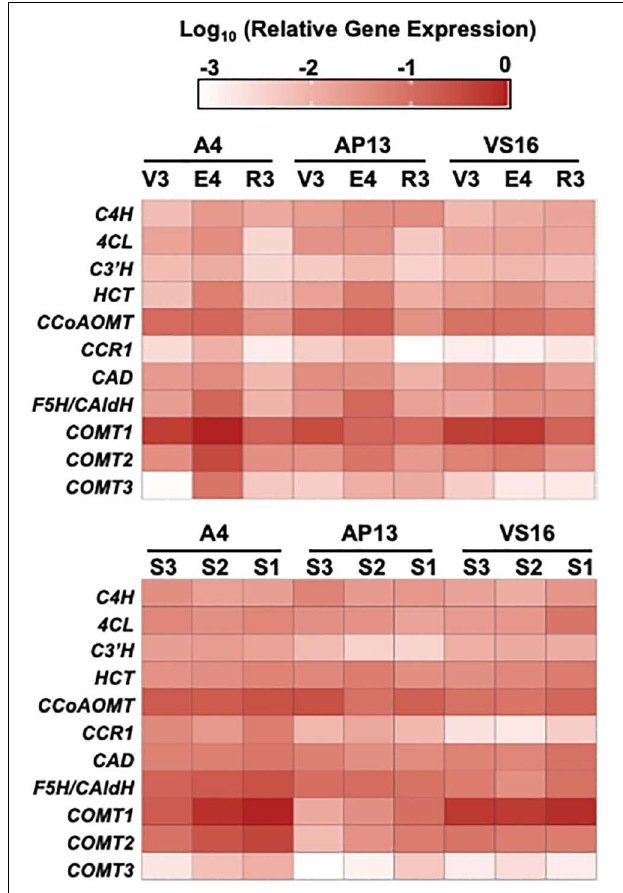
FIGURE 7 | Relative gene expression of phenylpropanoid biosynthesis genes by quantitative RT-PCR. (cid:49) Cq values, relative to switchgrass Ubi10 , were log 10 transformed. Color intensity indicates greater expression. 4CL, 4-coumarate:CoA ligase; C3’H, para -coumarate 3’-hydroxylase; C4H, cinnamate 4-hydroxylase; CAD, cinnamyl alcohol dehydrogenase; CCoAOMT, caffeoyl CoA O -methyltransferase; CCR, cinnamyl CoA reductase; COMT, caffeic acid 3- O -methyltransferase; F5H/Cald5H, ferulate 5-hydroxylase/ coniferaldehyde 5-hydroxylase; HCT, para -hydroxycinnamoyl-CoA: Quinate/shikimate p